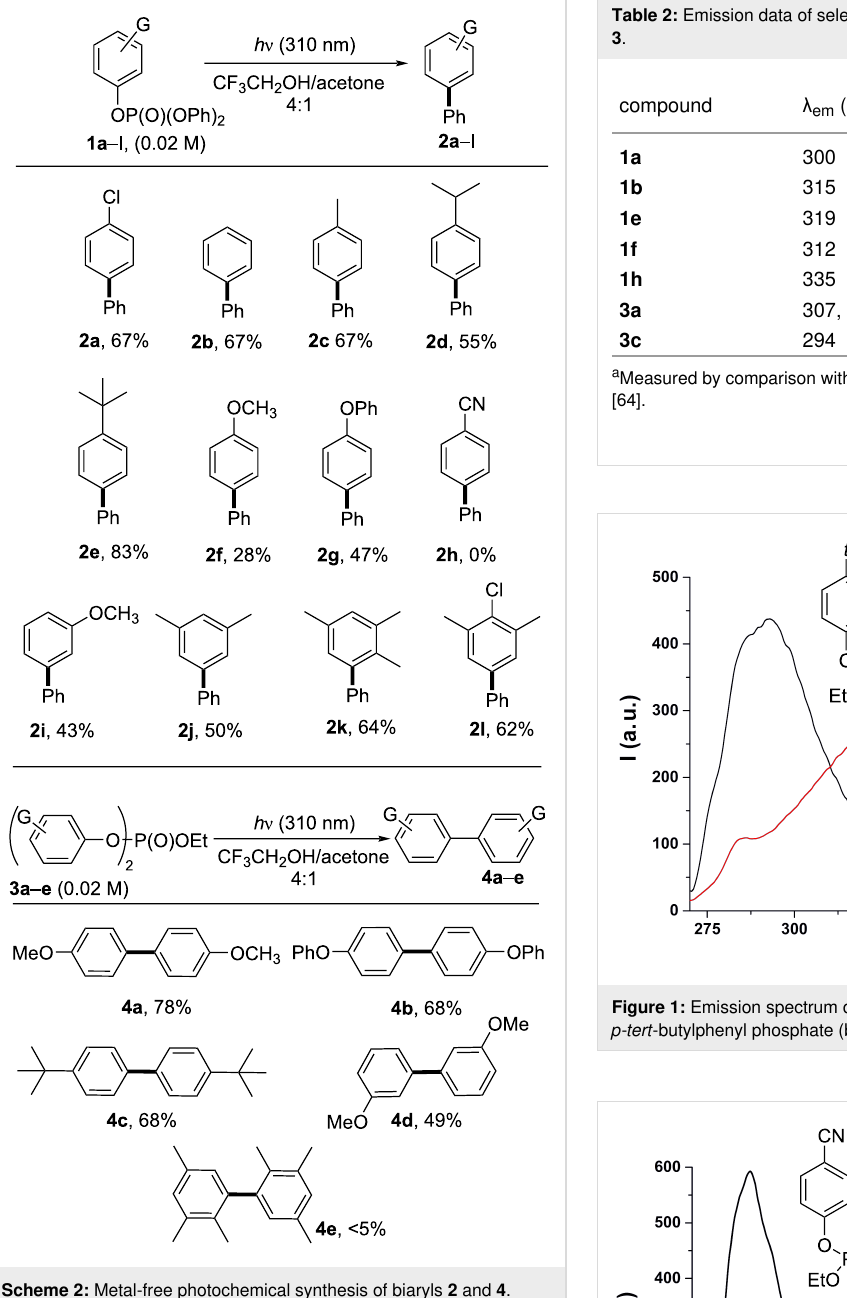
Figure 3) and their relative intensity was solvent dependent.